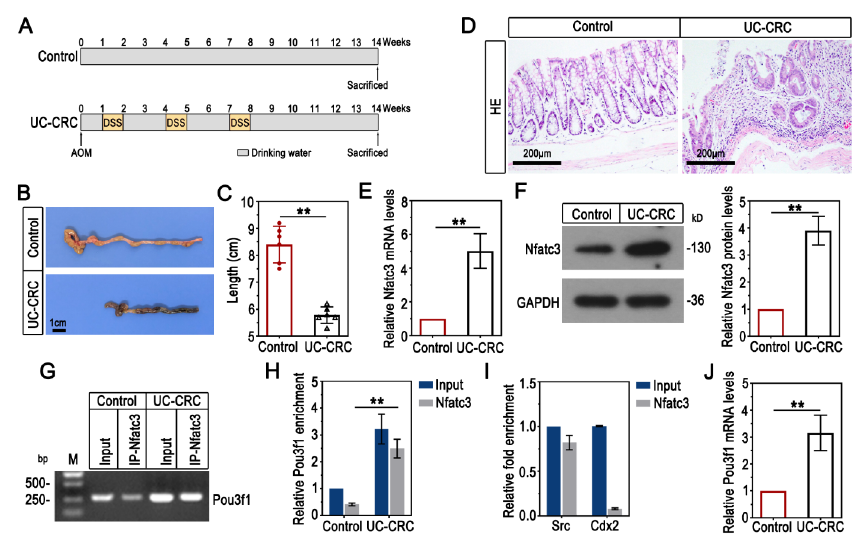
Fig. 1 Pou3f1 physically interacted with Nfatc3, and it was upregulated in colons of UC-CRC mice. (A) The sche- matic diagram for animal model protocol. (B-C) The colon length in mice was recorded. (D) Representative images of HE-stained colon sections. (E) Nfatc3 mRNA levels in colons were determined using qPCR. (F) Western blot analy- sis for Nfatc3 protein levels in colons and quantitative results. (G-H) ChIP-PCR and ChIP-qPCR were performed to determine the interaction between Nfatc3 and Pou3f1 in colons. M: Marker. (I) ChIP-qPCR assay showed that Nfatc3 bound to the Src promoter, rather than the Cdx2 promoter in colon tissues. Src was used as a positive control. Cdx2 was used as a negative control. (J) The relative mRNA levels of Pou3f1 were detected by qPCR analysis. Data were from n = 6 mice per group. Values were mean ± SD. **, p <